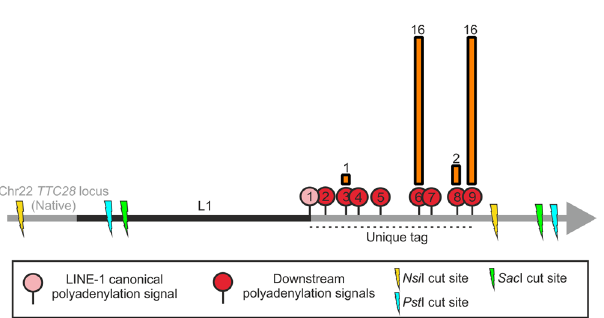
Figure 3. Read counts for insertions called by LDI-PCR.py. On the left, boxplots of read counts for insertions that were either detected (n = 14) or undetected (n = 25) by WGS. On the right, boxplots of read counts for insertions undetected by WGS that were either validated (n = 7) or unvalidated (n = 18). For better visualization, data are presented on a base-10 log scale.